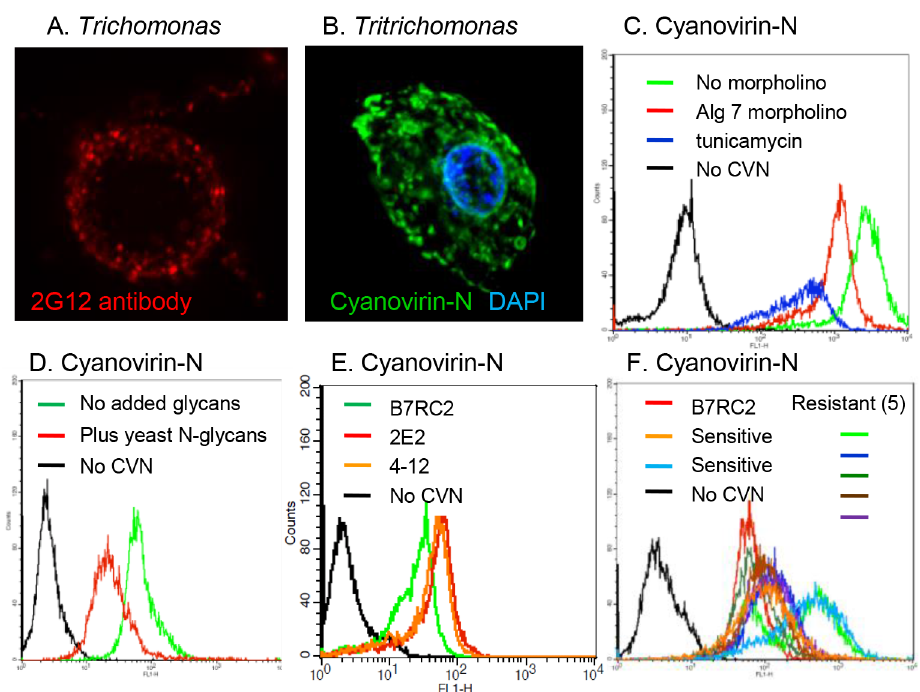
Fig 3. Anti-retroviral lectins and the 2G12 monoclonal antibody bind N -glycans of Trichomonas . A. Fluorescence micrographs show binding of griffithsin 2G12 antibody (red) to the surface of Trichomonas . B. Fluorescence micrograph shows binding of cyanovirin-N to the surface of Tritrichomonas . C. Flow cytometry shows that labeling with cyanovirin-N (green) is decreased when Trichomonas is treated with an Alg7 morpholino (red) or treated with tunicamycin (blue), both of which inhibit the first step in synthesis of the N - glycan precursor. D. Flow cytometry shows decreased binding of cyanovirin-N to Trichomonas (green) in the presence of N -glycans from the Saccharomyces mnn1/mmn4 double-knockout (red). E. Flow cytometry shows binding of cyanovirin-N to ricin resistant mutants (2E2 and 4 – 12) is slightly greater than binding to parent strain (B7RC2). F. Flow cytometry shows that binding of cyanovirin-N to two metronidazole-sensitive clinical isolates (bright blue and tan) and five metronidazole-resistant clinical isolates (green, dark blue, light blue, brown, and purple) from the CDC is as great or greater than binding of cyanovirin-N to B7RC2 (red), the parent strain for the ricin-resistant mutants.